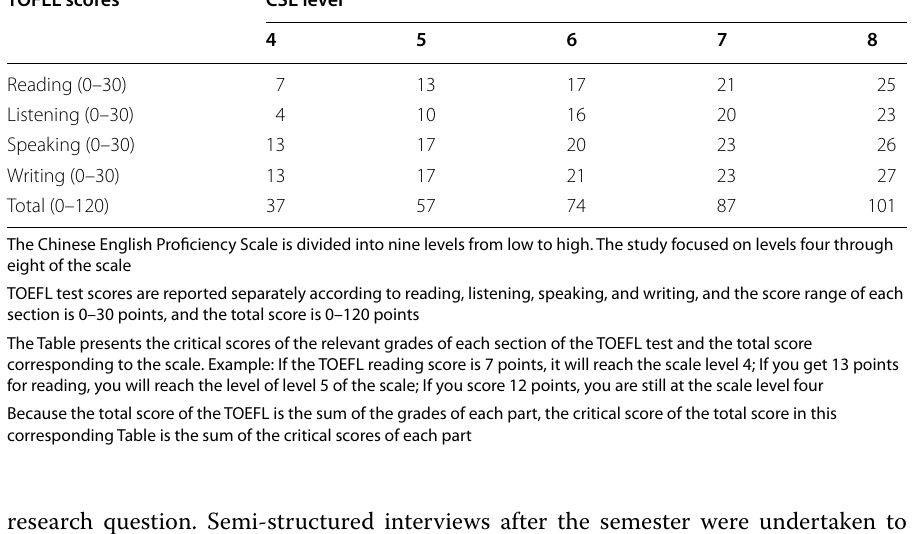
Table 1 TOFEL IBT test scores’ alignment to China’s Standards of English Language Ability (CSE)